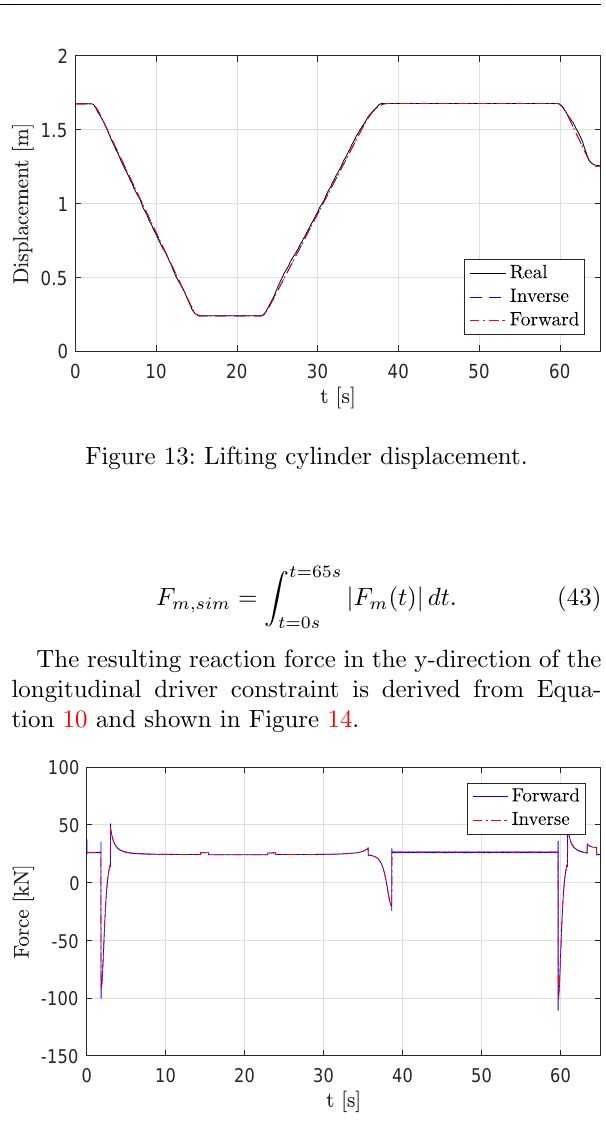
the longitudinal driver is read from Figure 14 to be F max = 100.8 kN at 59.7 s